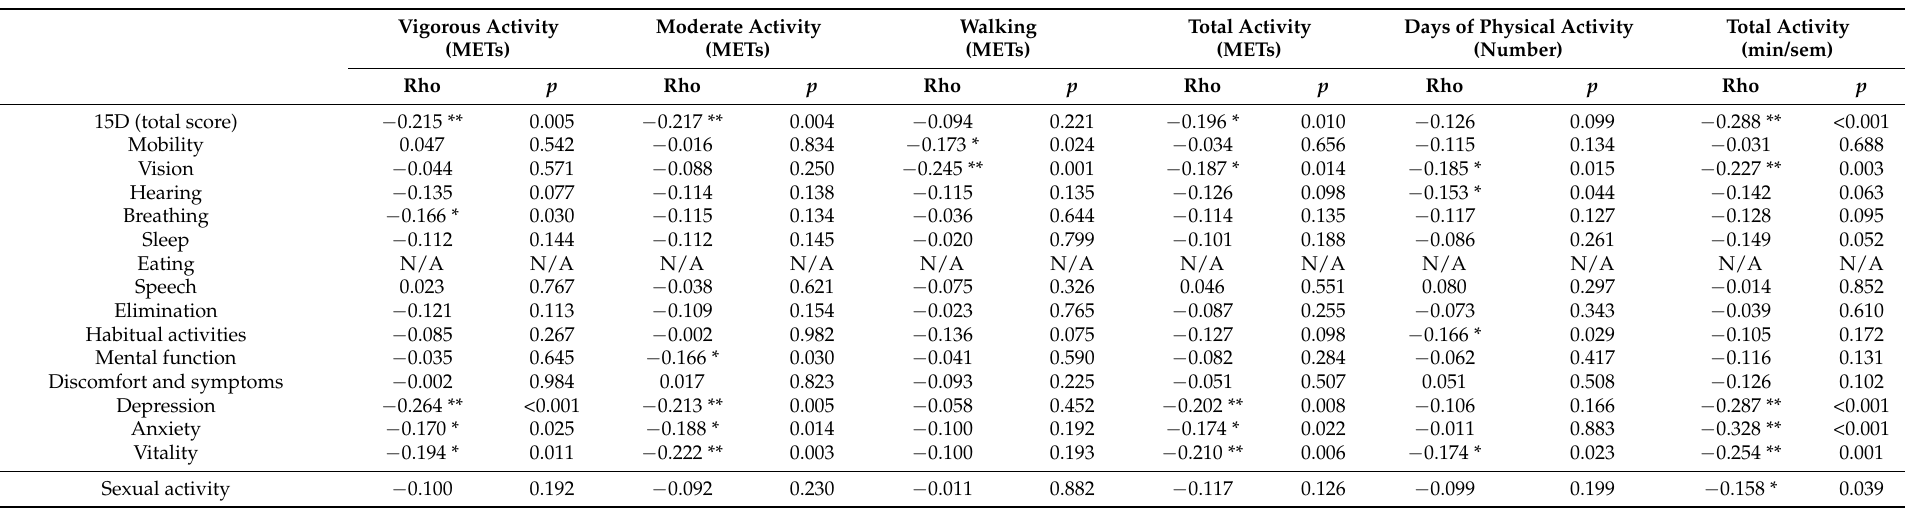
Table 4. Correlations between 15D and IPAQ questionnaires in the Type 1 Diabetes Mellitus population ( n = 172).